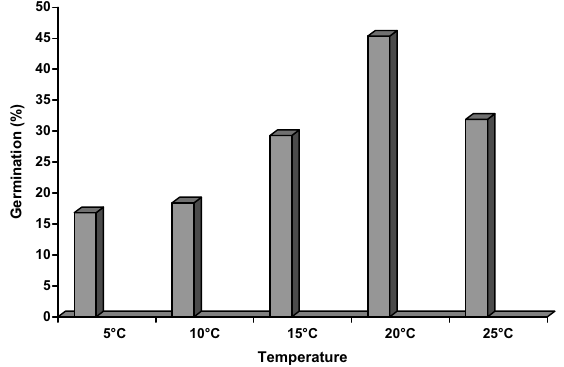
Fig. 1 – Effect of temperature on germination of progeny of C. album seed collected from Onion field.